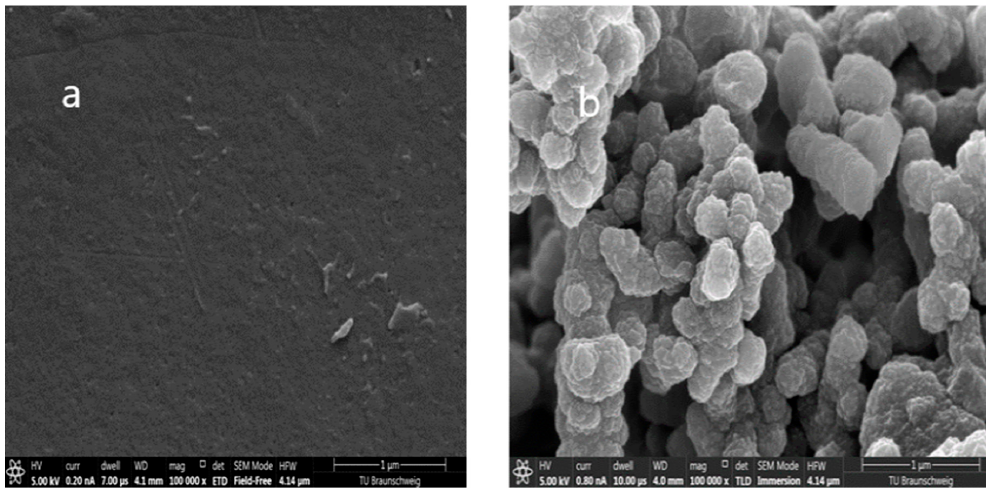
Figure 3. Scanning electron microscopy (SEM) image of ( a ) undoped PANI (b ) PANI doped with DBSA and sulfuric acid.